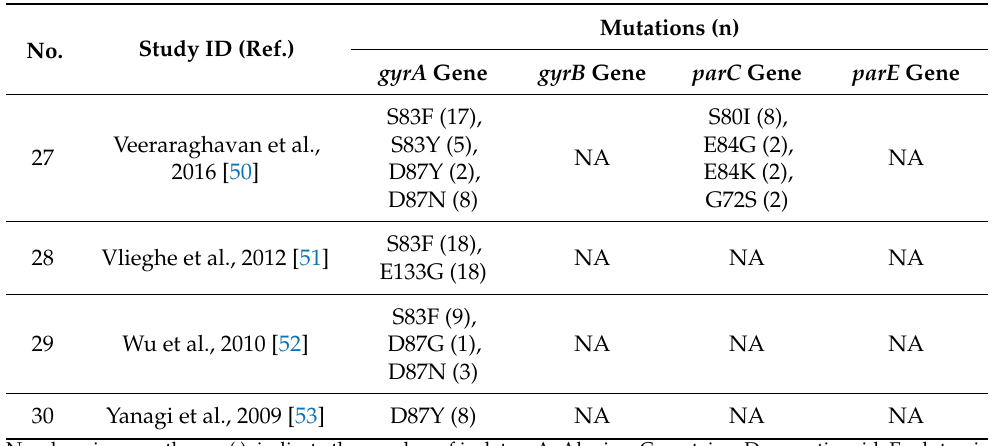
gyrA Gene gyrB Gene parC Gene parE Gene S83F (17), S83Y (5), D87Y (2), D87N (8) S83F (18), E133G (18) S83F (9), D87G (1), D87N (3)